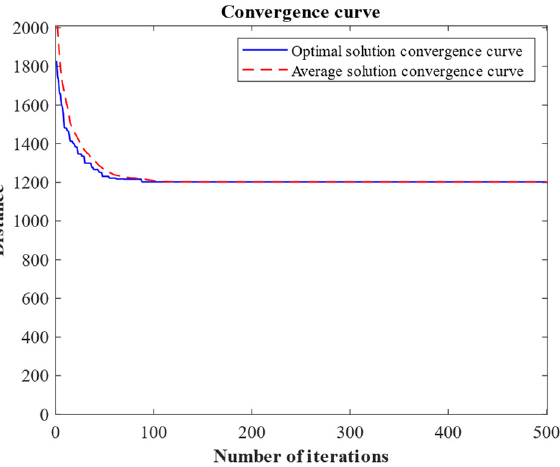
Figure 6. The optimization convergence curve of the cuckoo search algorithm when the number of locations to be visited is 20.